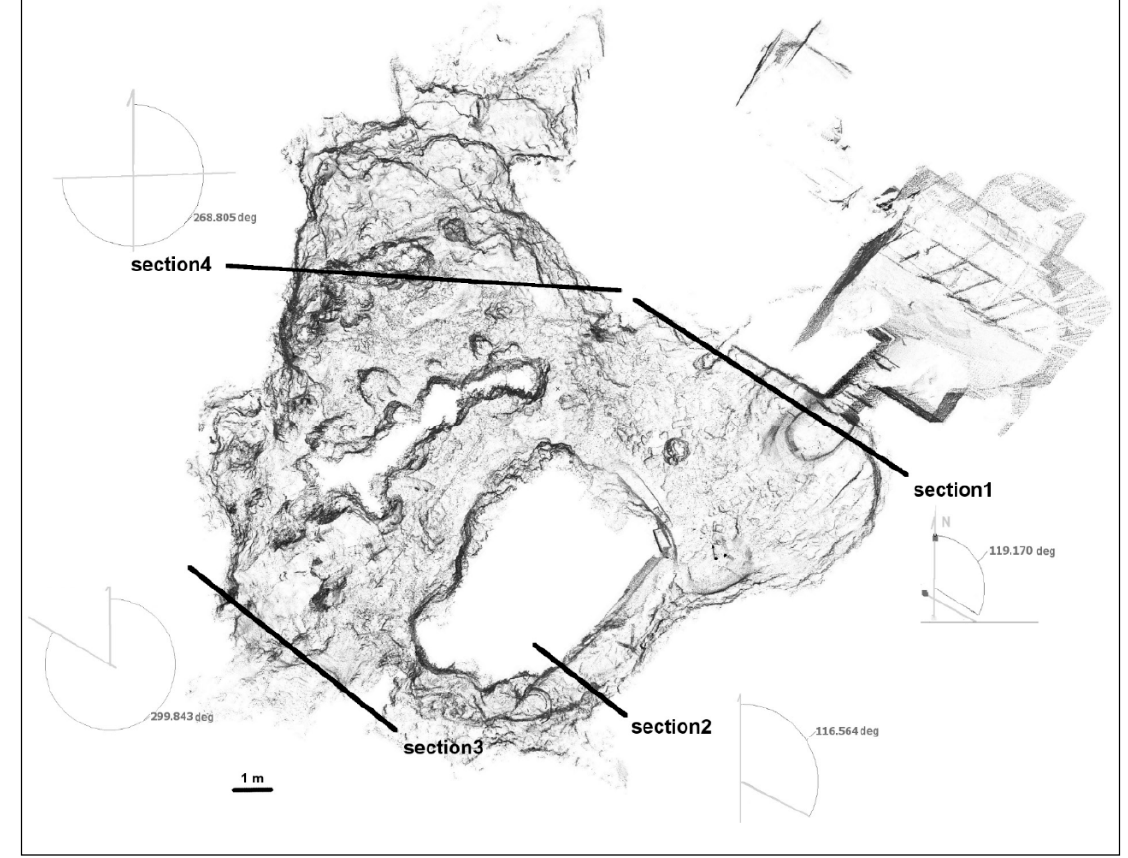
Figure 7. Section traces used for the kinematic analysis of the cave stability depicted on the 3D model, here shown as a map from the top view.